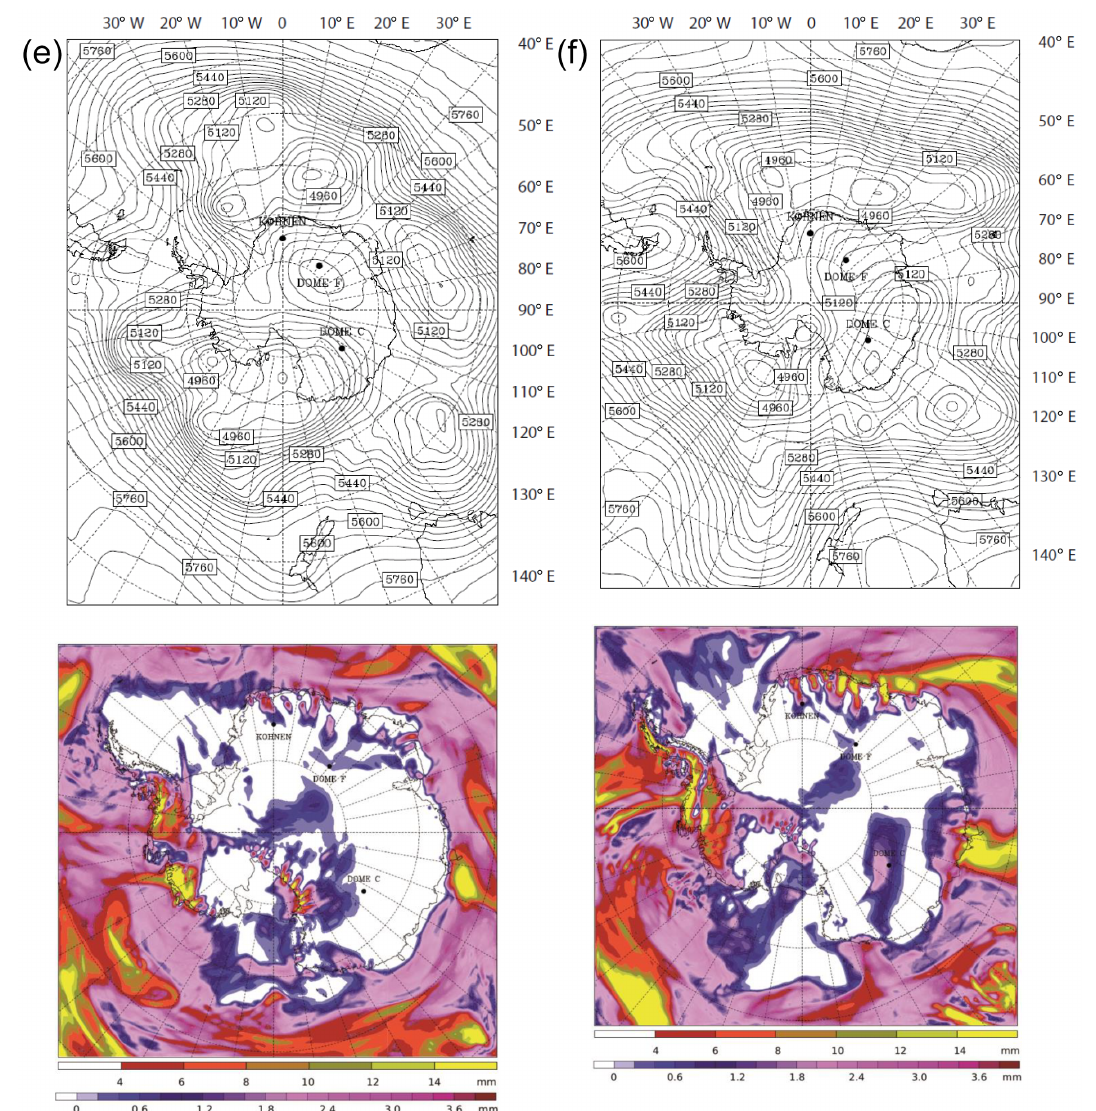
Figure 4. Synoptic patterns classification: 500hPa geopotential height (contour interval 10gpm) and 24h precipitation totals from AMPS archive for the different synoptic situations during precipitation: (a) blocking anticyclone with northwesterly flow (23 May 2007); (b) weak anticyclone with northwesterly flow (13 February 2007); (c) anticyclone with northeasterly flow (16 March 2007); (d) splitting of flow (14 August 2008); (e) southerly flow from West Antarctica (3 May 2007); (f) post-event (28 May 2007). The 500hPa geopotential height fields stem from AMPS 12h forecast of the preceding day, corresponding to 00:00UTC of the described day; precipitation is AMPS 12–36h forecast of the preceding day, corresponding to 00:00–24:00UTC of the day